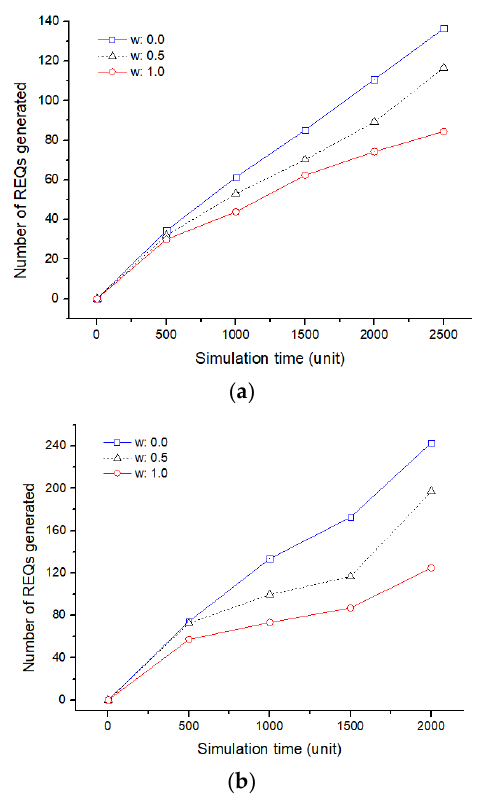
Figure 14. The number of total REQ messages generated: ( a ) A single sensing hole occurred; ( b ) two sensing holes occurred.